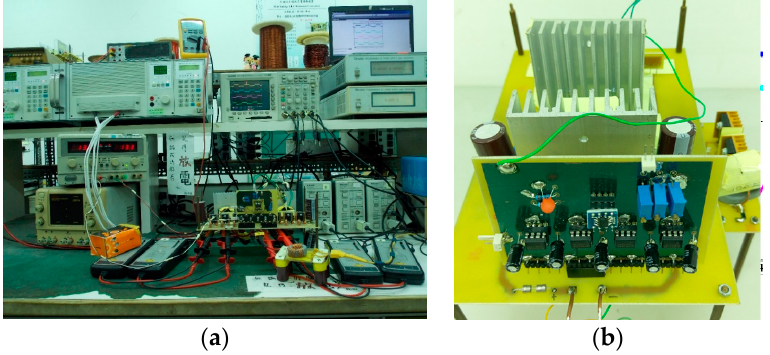
Figure 13. Pictures of the studied converter in the laboratory: ( a ) experimental setup, ( b ) prototype circuit.